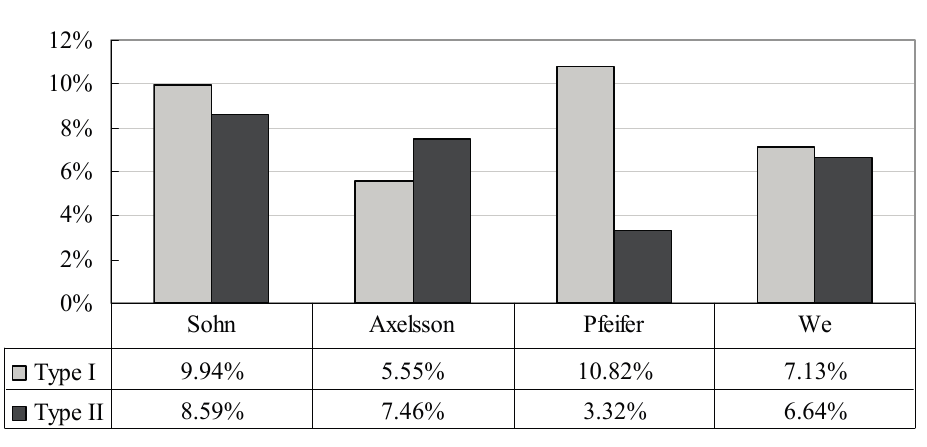
Figure 8. Averages of type I errors and type II errors produced by different filters.